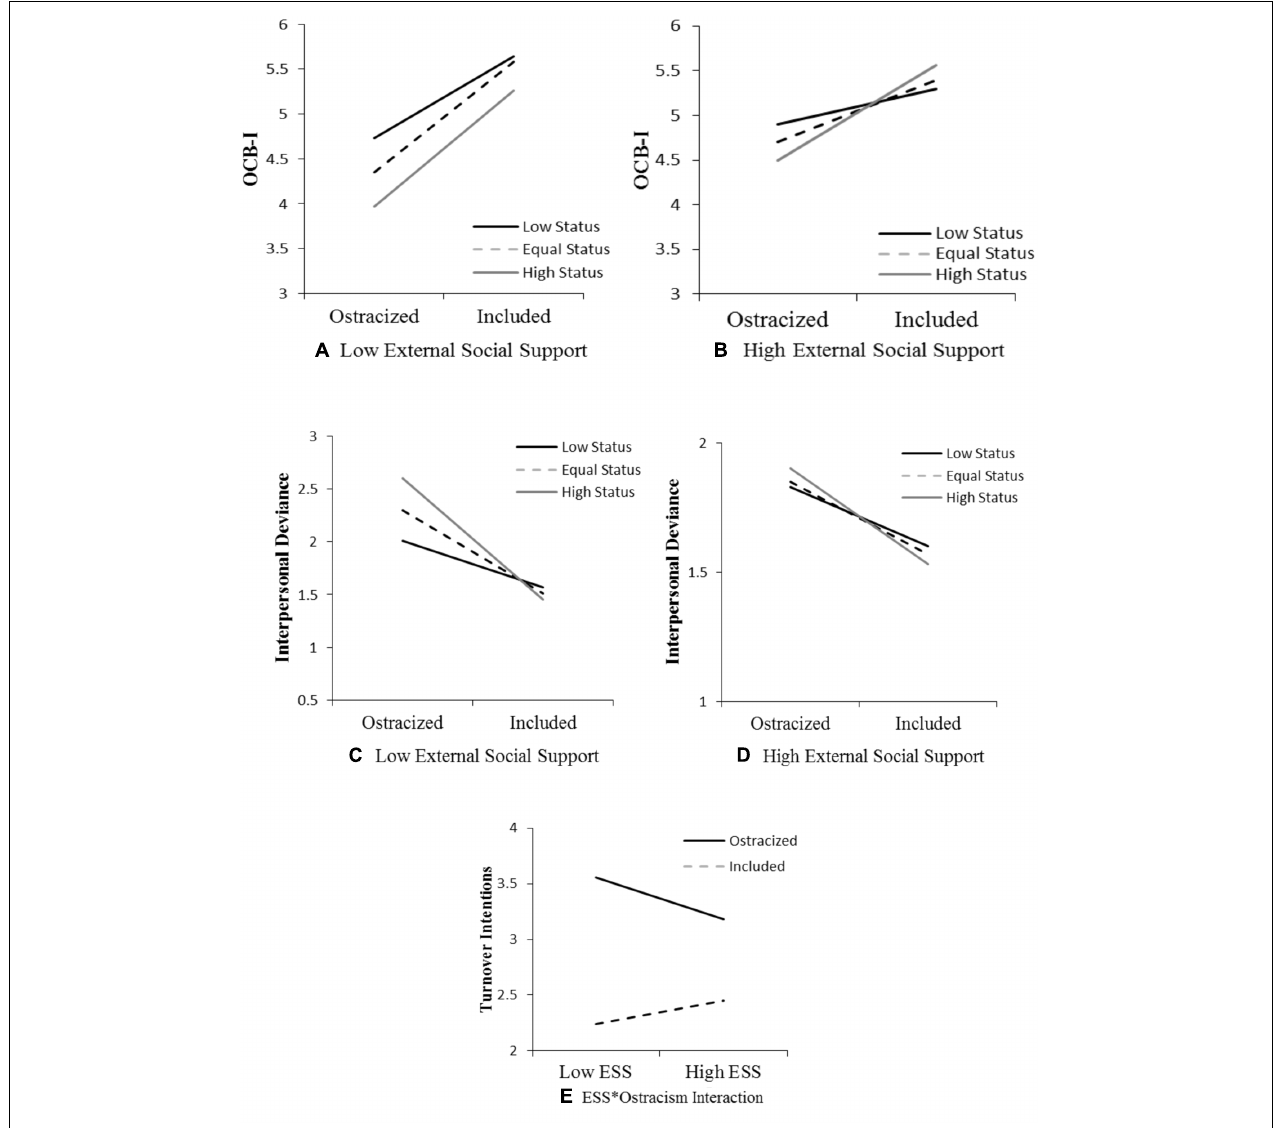
FIGURE 1 | Study 1: Moderation effects of ostracizer status and external social support. OCB-I, organizational citizenship behavior-individual; ESS, external social